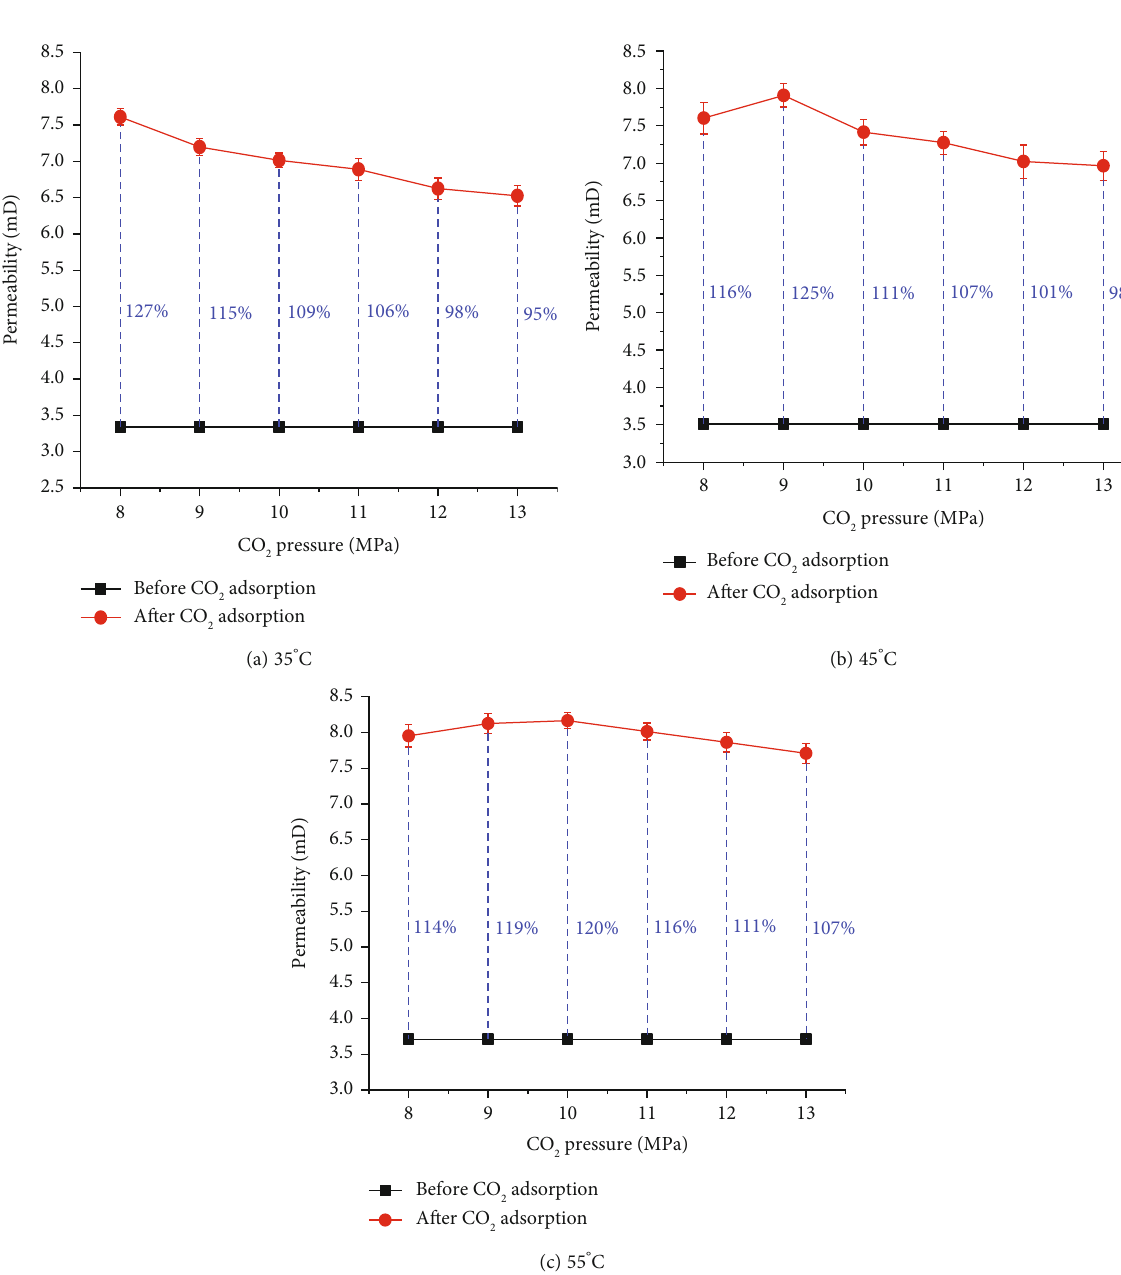
Figure 3: Permeability enhancement at di ff erent